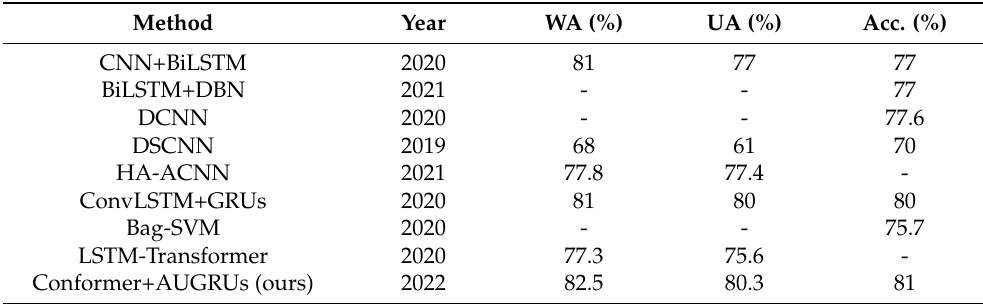
Table 4. Accuracy summary of various models obtained using RAVDESS database. WA is the weighted accuracy and UA is the unweighted